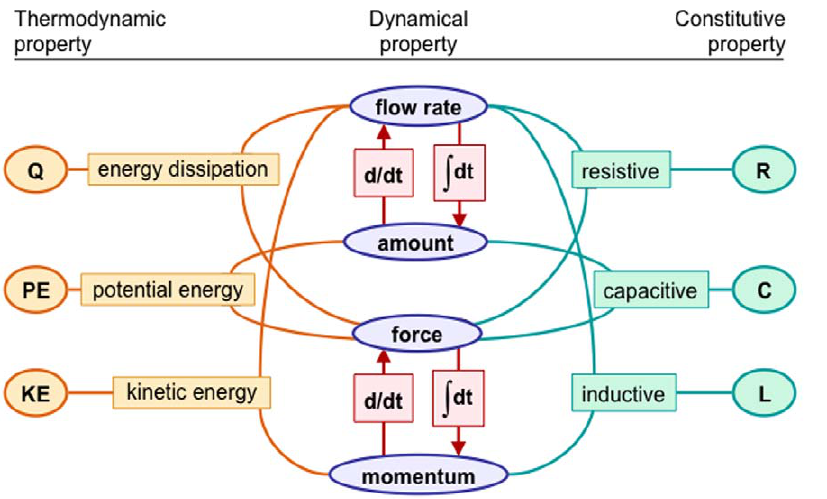
Figure 2. Foundational physical theory of OPB. Framework in which physical properties (ovals) are linked by quantitative dependency relations (rectangles) between the quantitative magnitudes of properties. For example, Ohm’s law is a resistive dependency between electrical current (I, a flow rate), voltage differential (V, a force), and electrical resistance (R, a resistive constitutive property). This schema applies, wholly or in part, to properties in various physical domains (e.g., fluids, electricity, chemistry) and are the basis for analogies between property types. (Q=rate of heat dissipation, PE=potential energy, KE=kinetic energy, R=resistance, C=capacitance, L=inductance.).